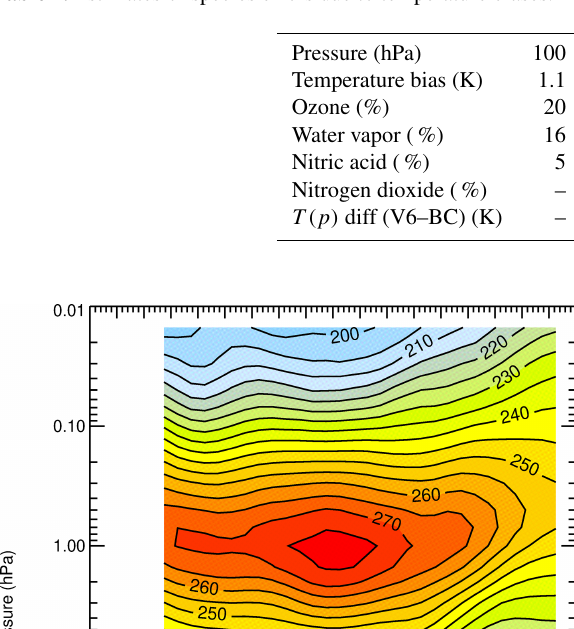
Table 1. Estimates of species errors due to temperature biases.